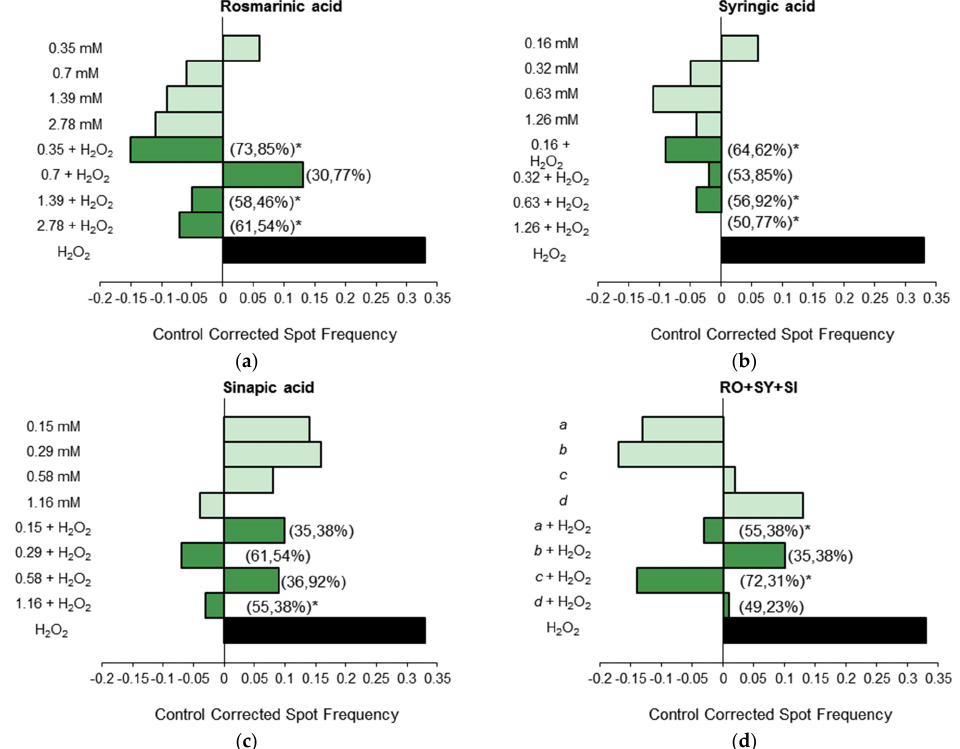
Figure 2. Antigenotoxic activity of Borago officinalis bioactive compounds: ( a ) RO, ( b ) SY, ( c ) SI and ( d ) mixture (RO+SY+SI) expressed as mutation frequency corrected to control. Strength of inhibition on the capability of H 2 O 2 (0.12 M) to induce mutated cells is also shown (Inhibition Percentage in brackets). Light green columns correspond with tested concentrations of simple treatments, green with combined treatments and black column corresponds to spot frequencies induced by H 2 O 2 . Letters a , b , c and d in graphic ( d ) correspond to the lowest, two intermediate and highest concentrations respectively assayed for each single compound once their mixture is assayed. * Significance levels with respect to the positive control (H 2 O 2 ) group (p ≤ 0.05).